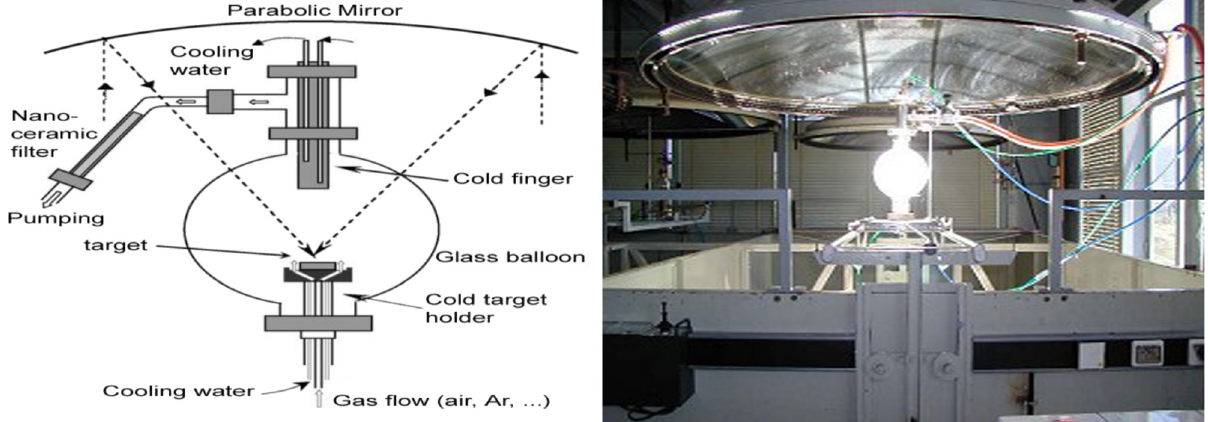
Fig. 1. (a) SPVD reactor schema; (b) SPVD